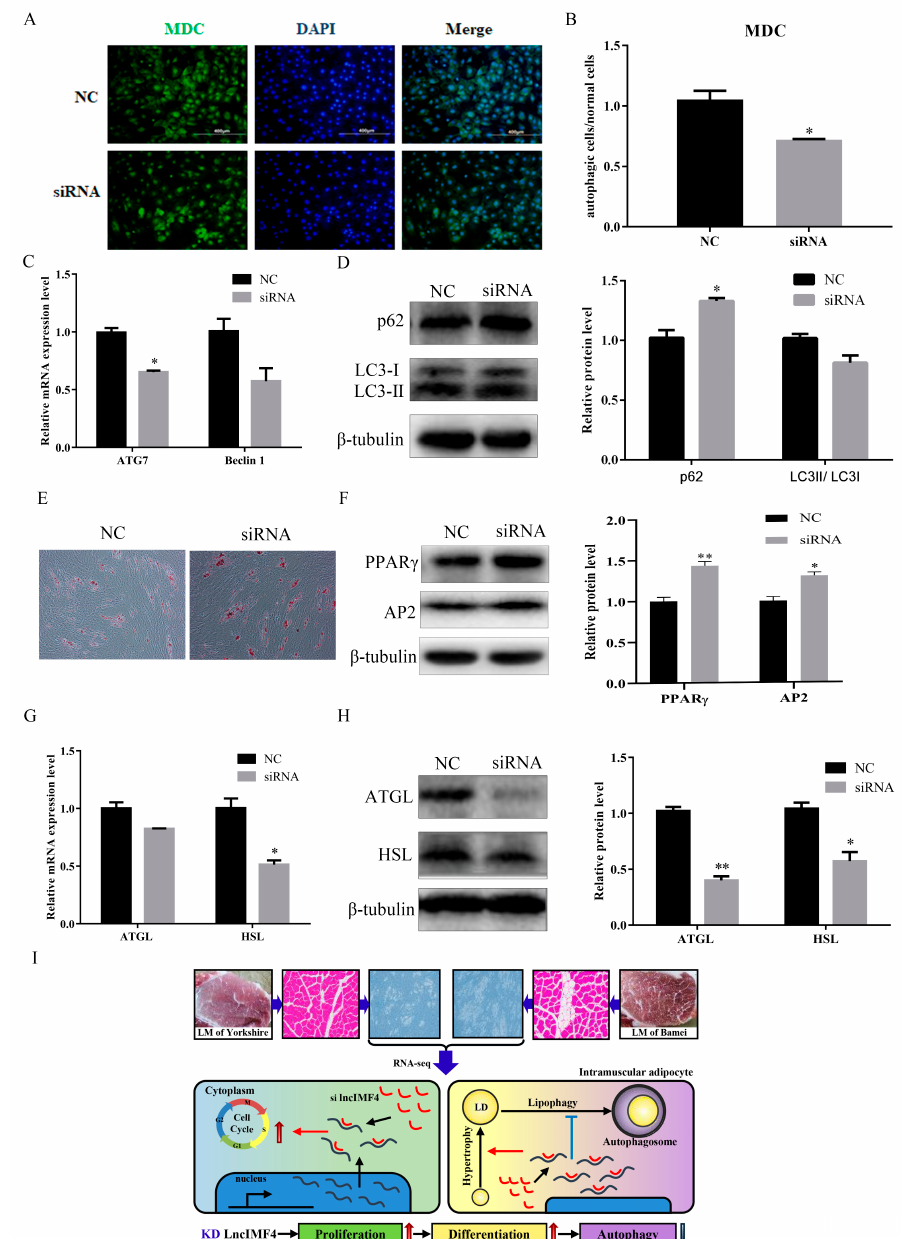
Figure 6. Knockdown of lncIMF4 inhibited lipolysis by downregulating autophagy. ( A ) MDC staining of porcine intramuscular adipocytes transfected into cells at 70% density at 50 nM after inducing autophagy by serum-free medium for 3 h. ( B ) The quantification of autophagic cells / normal cells. ( C ) RT-qPCR was carried out to detect the cell autophagic genes. ( D ) Western blot analysis of autophagic marker genes on 6 day of differentiation. ( E ) Oil Red O staining, scale bar = 100 μ m. ( F ) Western blot analysis of adipogenic genes on 6 day of differentiation in autophagy model. ( G ) The mRNA expression level of lipolytic genes on 6 day of differentiation. ( H ) Western blot analysis and quantification of lipolytic protein levels. ( I ) The function of lncIMF4 in porcine intramuscular adipocytes. Data were representative of means ± SEM of three independent experiments. *, p < 0.05; **, p <0.01.